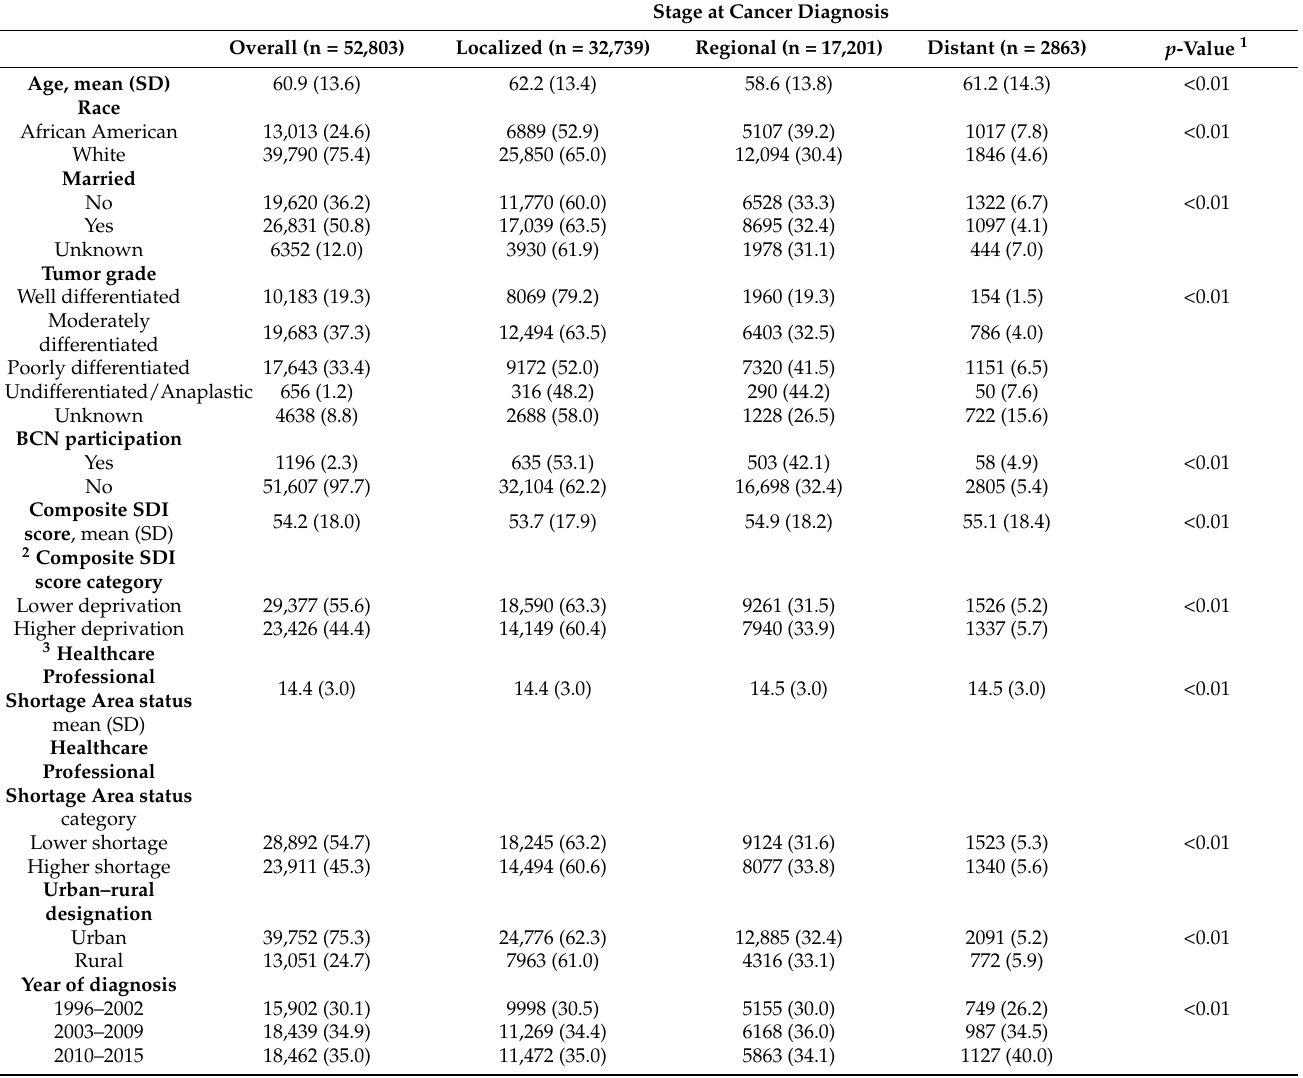
Table 1. Sample characteristics, overall and by stage at cancer diagnosis (n = 52,803). Stage at Cancer